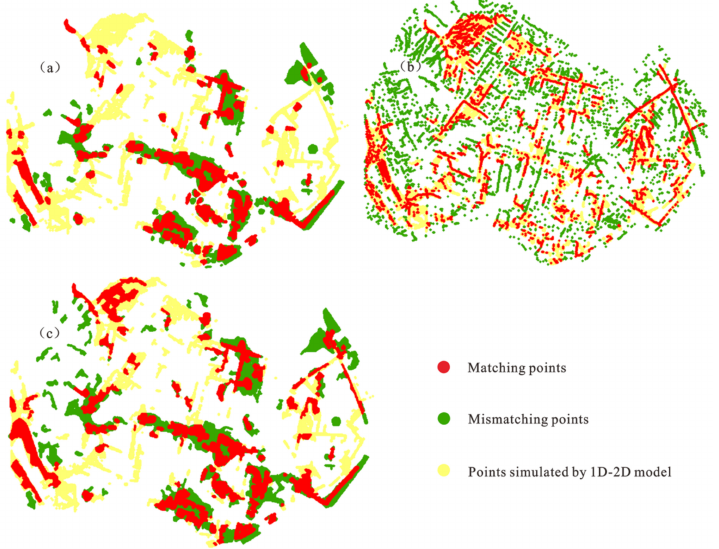
Figure 9. Spatial illustrations of the flood maps using optimized ( a ) DE, ( b ) TWI and ( c ) refined methods based on the F3